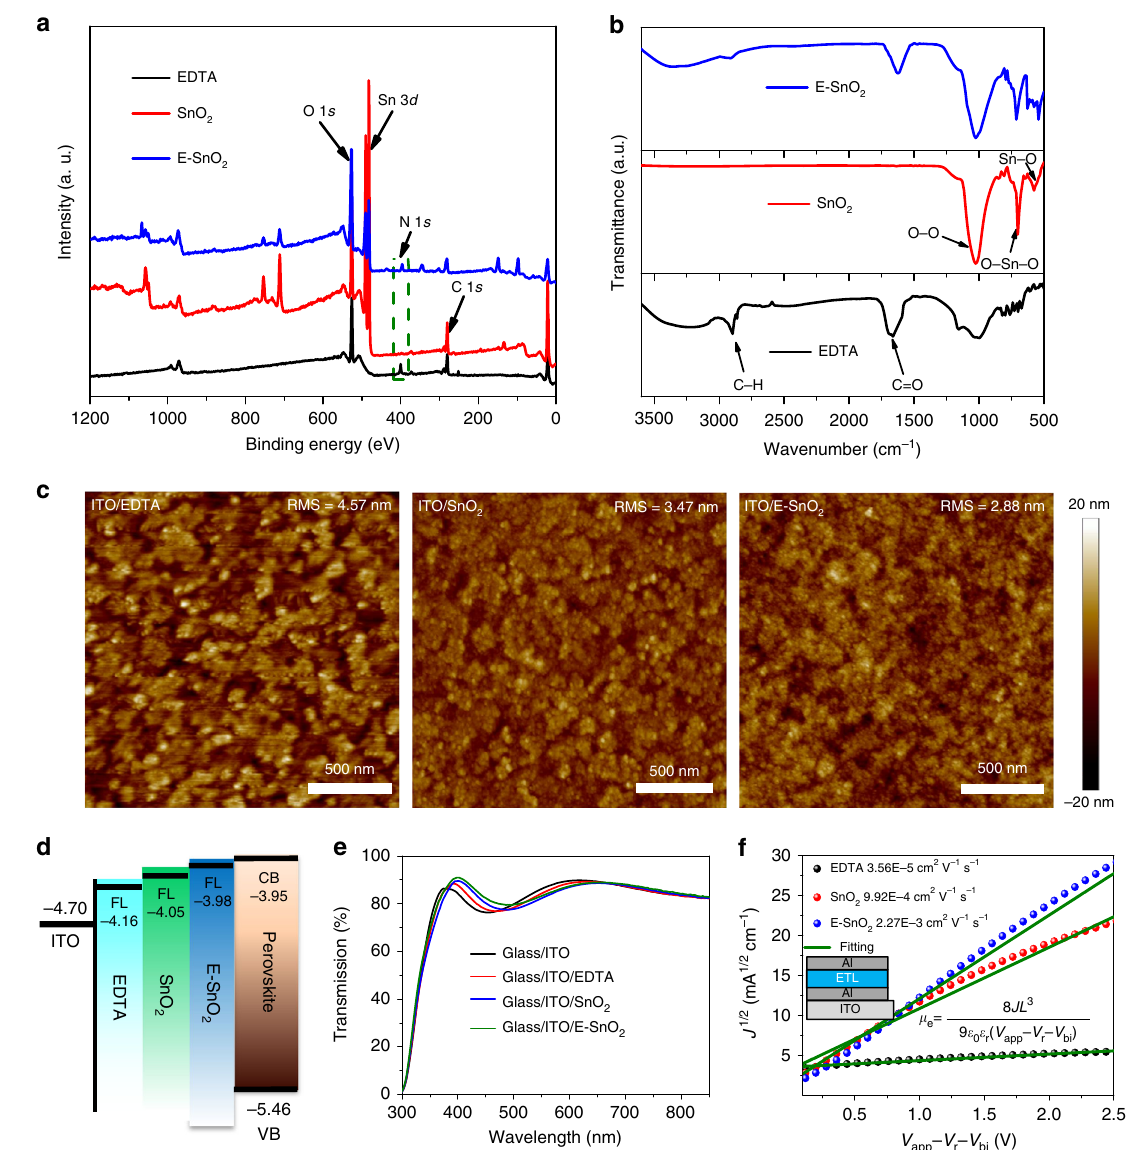
Fig. 1 Characterization of the ETLs. a XPS and b FTIR spectra of EDTA, SnO 2 , and E-SnO 2 fi lms deposited on quartz substrates. c AFM topographical images of EDTA, SnO 2 , and E-SnO 2 fi lms. d Schematic illustration of Fermi level of EDTA, SnO 2 , and E-SnO 2 relative to the conduction band of the perovskite layer. The Fermi level of EDTA, SnO 2 , and E-SnO 2 is measured by KPFM, and the conduction and valence band of the perovskite materials are obtained from the previous report 74 . e Optical transmission spectra of EDTA, SnO 2 , and E-SnO 2 fi lms on ITO substrates. f Electron mobility for EDTA, SnO 2 , and E-SnO 2 using the SCLC model, and the inset shows the device structure of